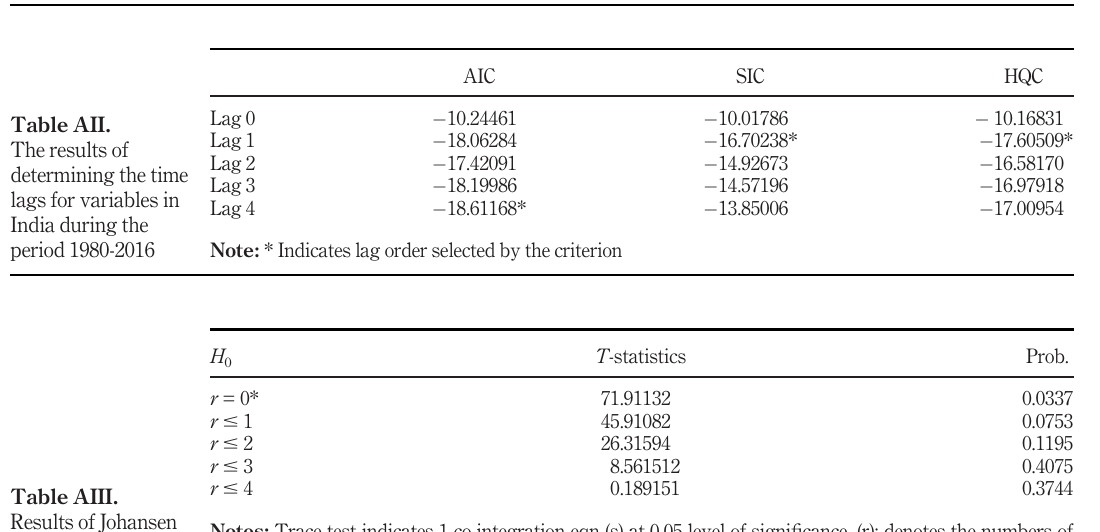
Table AIII. Results of Johansen cointegration test (trace), Lag 1